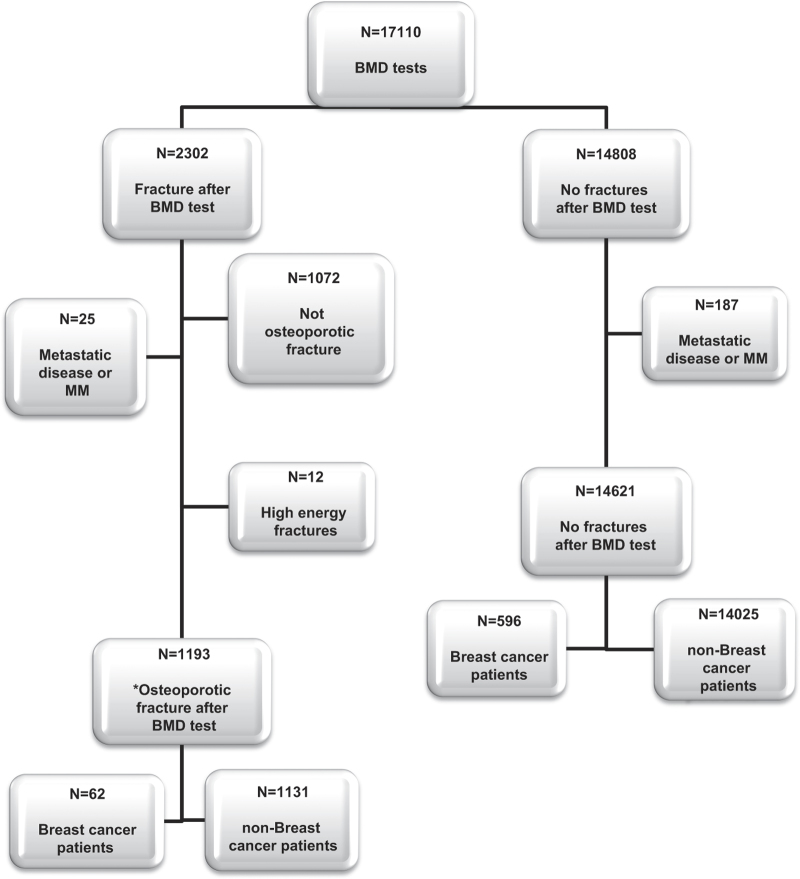
Flow chart of study population. *Osteoporotic fracture defined as hip, vertebral, distal radius, humerus, and ribs fractures.